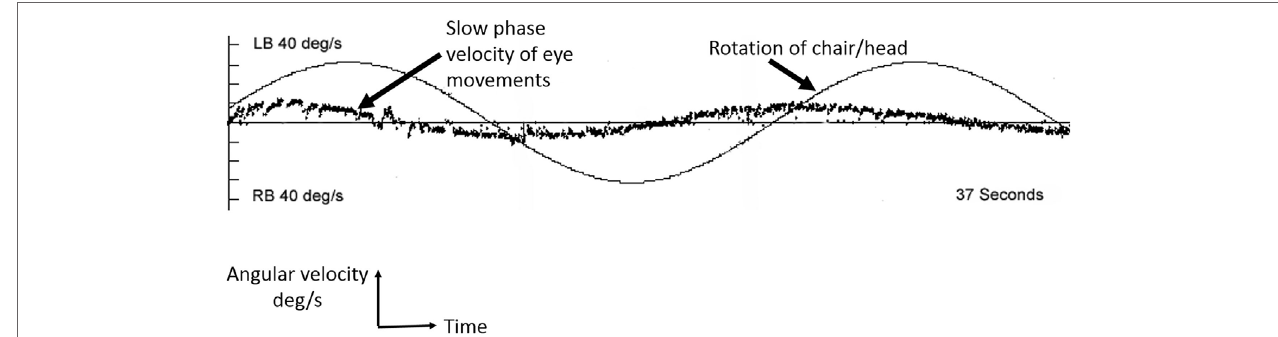
FIgURe 1 | Example of vestibular hypofunction seen across all frequencies for Case 1. A sinusoidal rotation at 0.04 Hz, 60 deg/s by rotational chair testing. The smooth sinusoid is the chair/head rotation at 0.04 Hz, and the scatter line represents the slow phases of compensatory nystagmus in response to the sinusoidal head (and chair) rotations. The abscissa is time measured in seconds. LB, left beating nystagmus; RB, right beating nystagmus. Performed using Micromedical Technologies (Chatham, IL,